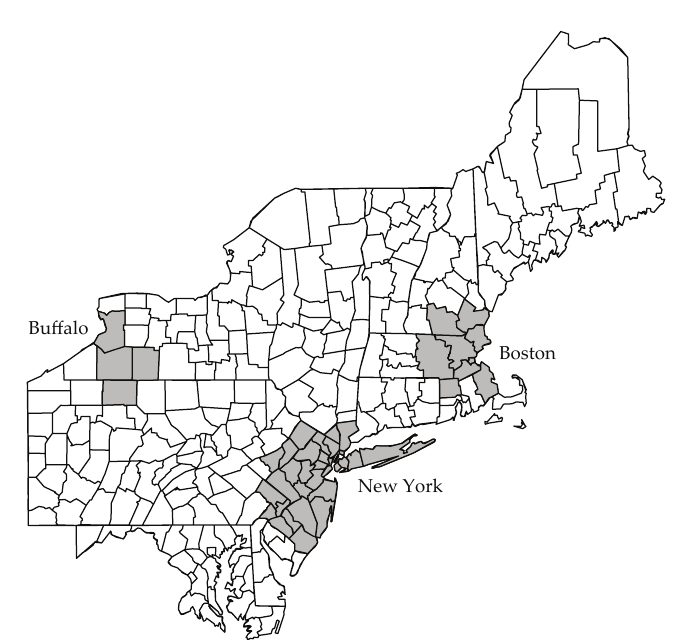
Figure 1: The most likely cluster and the second most likely cluster using the standard scan method and the sequential scan method. The most likely cluster is around New York City, the second most likely cluster detected using the standard method is close to Bu ff alo and it is not significant. The second most likely cluster detected using the sequential method is around Boston and it is significant.